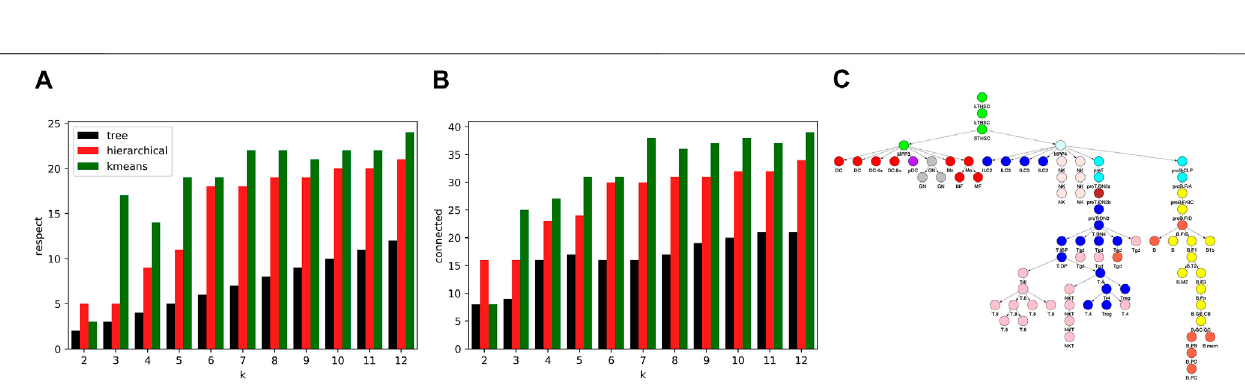
FIGURE 7 | Comparison of cell type clustering across methods. To compare the form of clusters between our tree based method and hierarchical and kmeans methods, we decomposed clusters into components that respected the tree and that were connected. Shown are the sum across clusters of components that (A) respect thetreeand (B) areconnectedrelative tothetree.Thenumber ofcomponentsgeneratedbyourmethodislessacrossallvaluesof k . (C) Shown aretheclusters formed using hierarchical clusteringfor k (cid:1) 12.Asanexampleofthecomponentcounts, theblueclusterisformed from3componentsthatrespect thetreeandsix connected components. Note that the clusters are more dispersed on the tree than the clusters of Figure 4C .